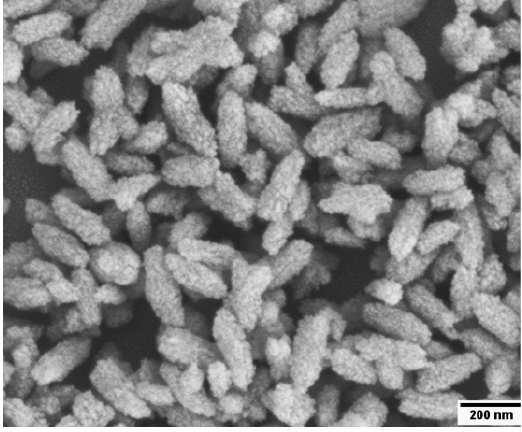
Figure 1. SEM image of the prepared rod-like calcium carbonate nanoparticles (Rod-CC NPs).